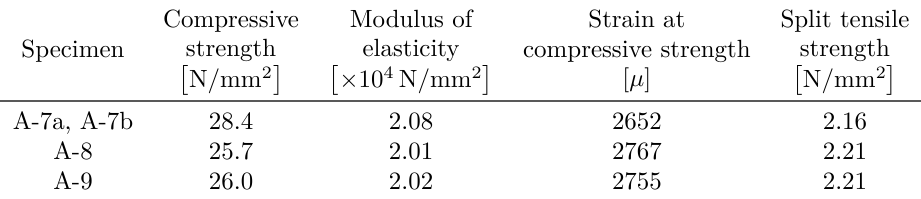
Table 3. Material Properties of